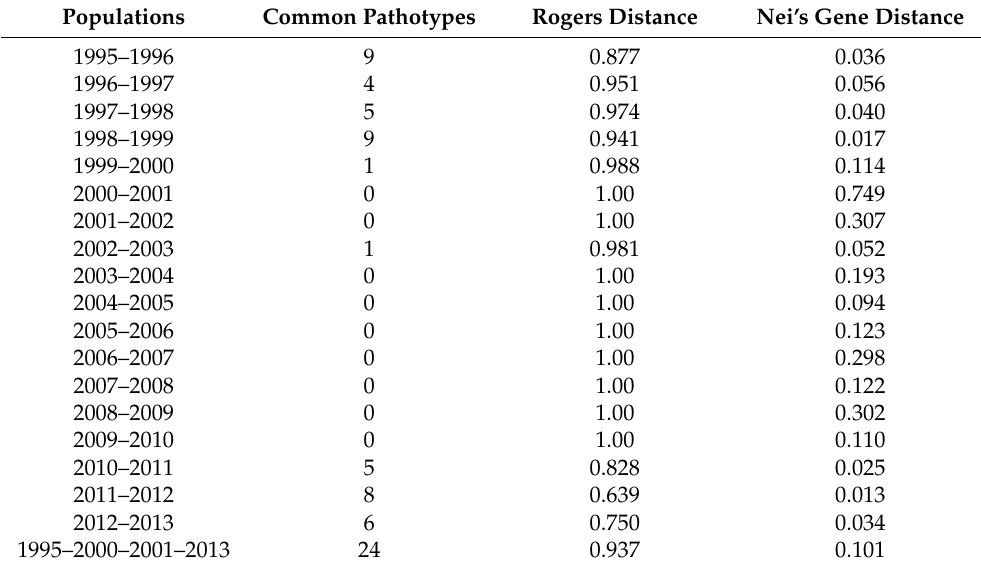
Table 6. Distance between powdery mildew populations.